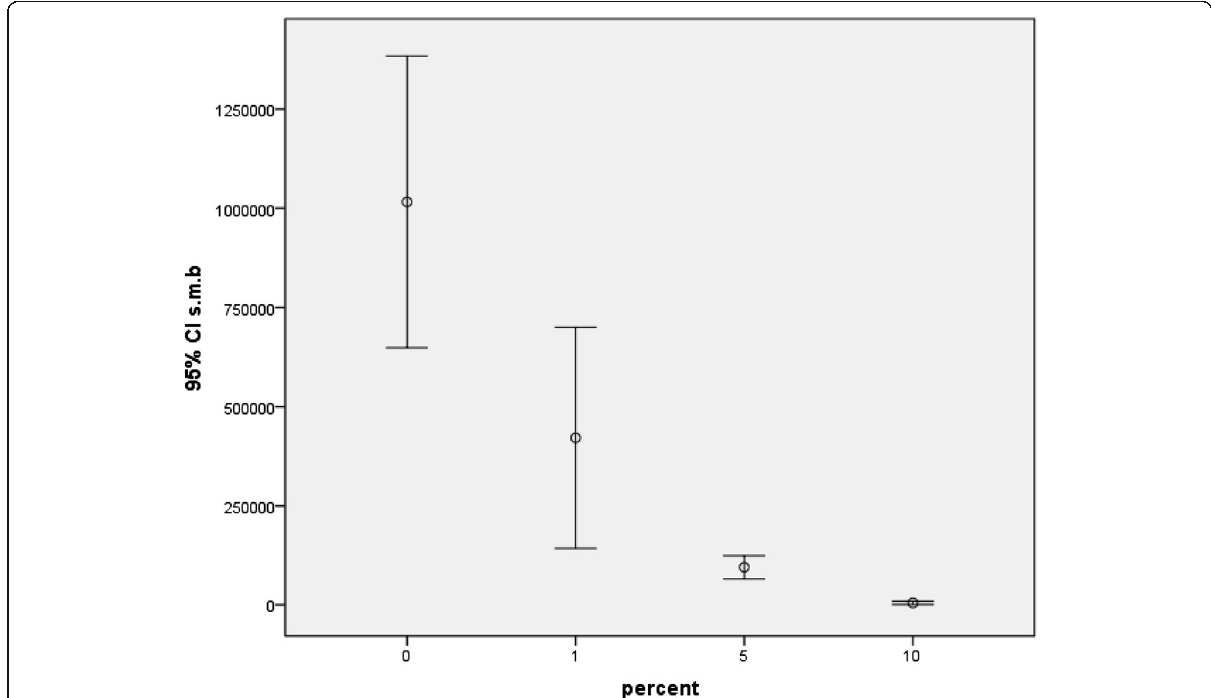
Fig. 3 Viable counts of S. mutans biofilms on composite discs containing 0, 1, 5, and 10 % Ag/HA